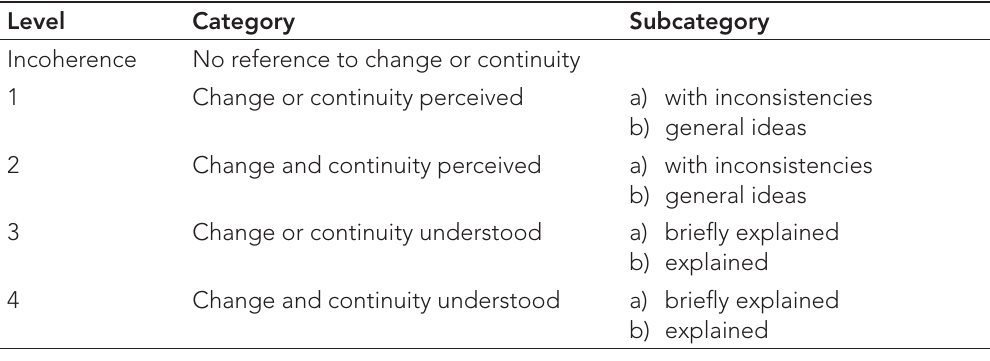
Table 1: Categories of progression suggested by the research findings Level Category Subcategory